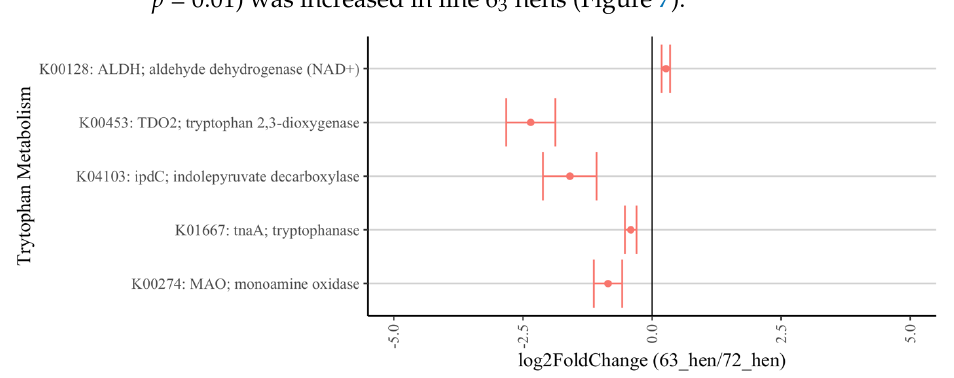
Figure 7. Relative abundance of tryptophan metabolism on KEGG orthology between diversely selected 6 3 -hens and 7 2 -hens. Positive “log 2 fold change” values (x-axis) indicate higher expression of certain pathways in 6 3 -hens and negative values indicate higher expression in 7 2 -hens.